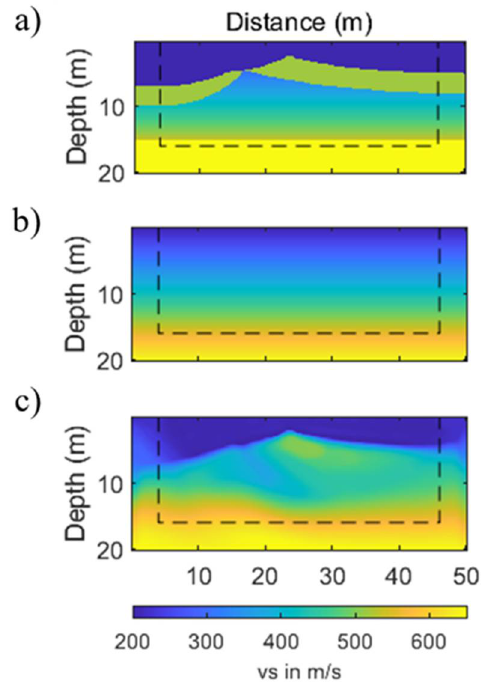
Figure 7. Multi-parameter synthetic example when using a high-frequency source signal: ( a ) the true S- wave velocity model for the calculation of the observed data, ( b ) the initial S- wave velocity model, and ( c ) the inverted S- wave velocity model. The CPML frame is marked by a thin black line.